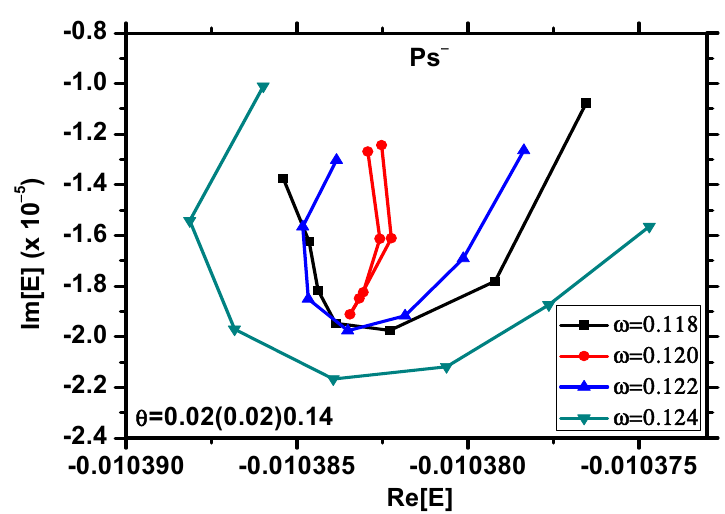
Figure 5. The rotational paths near the pole for the 1 P° (7) FR of Ps − lying below the Ps ( N = 5 ) threshold in the EP for four different values of the scaling parameter ω using 900-term ECW. Table 2. The 1 P° Feshbach and shape RP (in eV) in Ps − associated with the N = 2, 3, 4, 5 Ps thresholds. The resonance positions are measured from the ground state of the Ps − ion. Present Calculations